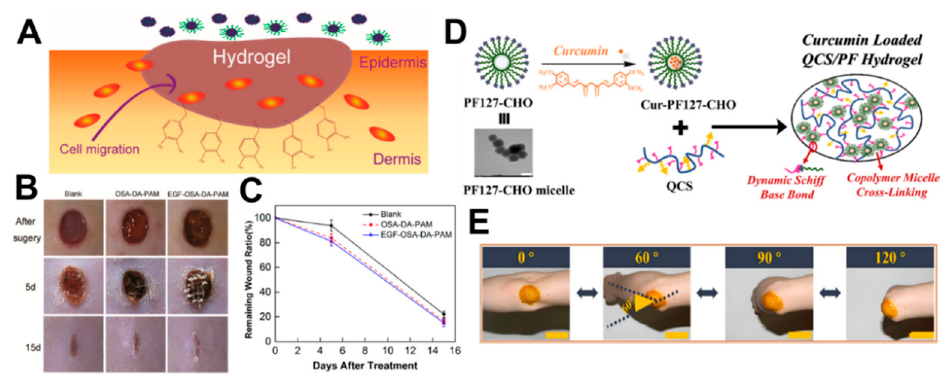
Figure 11. ( A ) The schematic diagram of tissue adhesive hydrogels. ( B ) Optical images of wound sites were taken on days 0, 5, and 15 after surgery. ( C ) Remaining wound ratios for each group. Reprinted with permission [99]. © 2018, American Chemical Society (Washington, DC, USA). ( D ) The schematic illustration of the Cur-QCS / PF hydrogel and the transmission electron microscope image of PF (i.e., PF127-CHO) micelles. Scale bar: 200 nm. ( E ) The photograph of Cur-QCS / PF hydrogels that were applied on the human elbow. Scale bar: 5 cm. Reprinted with permission [70]. © 2018, Elsevier Ltd. (Amsterdam, The Netherlands).